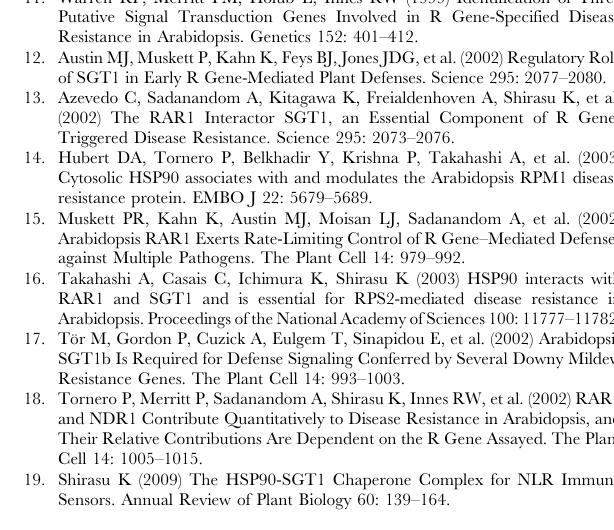
Figure S6 The reductions of RPM1-myc levels in the 35S:SGT1b-HA transgenic plants are not due to the decrease of HSP90 protein level or the silencing of RPM1-myc gene. (A) Western blot analysis of RPM1-myc, SGT1b, SGT1a, and HSP90 protein levels for the indicated genotypes. RuBisCo levels stained by Coomassie Brilliant Blue serve as loading control; (B) RT- qPCR analysis of the expression of RPM1 and RPM1-myc for the indicated genotypes. The western blot and RT-qPCR assay were performed independently a minimum of two times with similar results. (TIF) Table S1 Both of the coi1 rsp mutants are completely recessive. (DOC) Table S2 Non-allelic non-complementation between coi1 rsp and hsp90 rsp mutants. RPM1-mediated resistance was tested by spray- inoculation with Pto DC3000( avrRpm1 ). Disease symptoms were evaluated 5 days after inoculation. Table S3 Phenotypic similarities among coi1 , sgt1b , and hsp90.2 mutants. (DOC) Text S1 Supporting information including the primers and corresponding enzymes for selecting of mutations, the primers for making 35S::SGT1b-HA construct, the primers used for